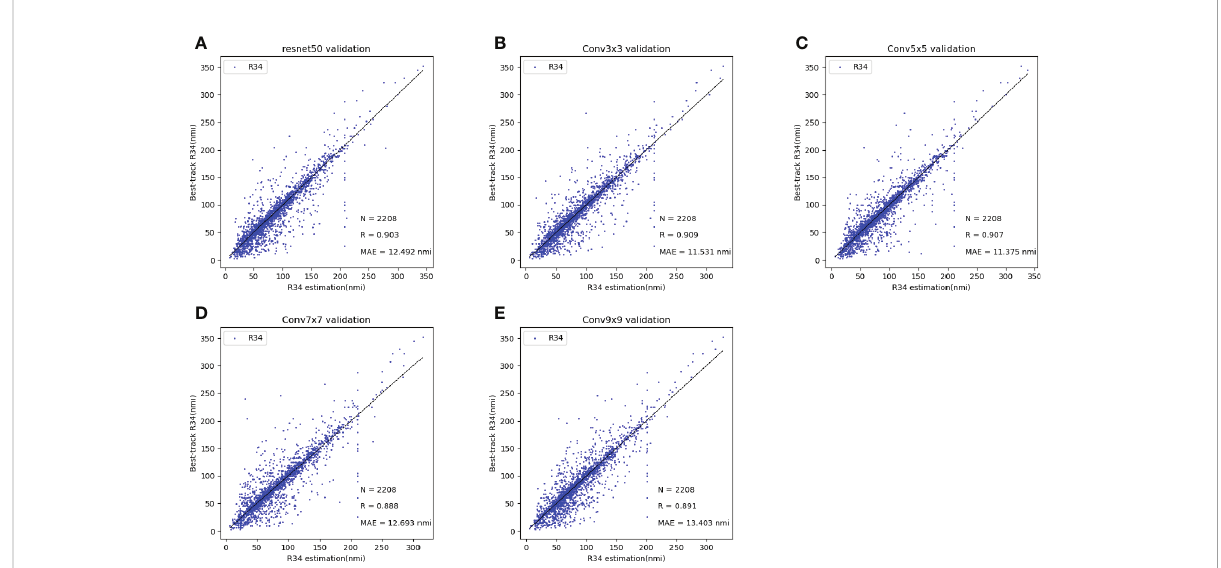
FIGURE 11 Scatterplot of different parameter settings on validation set. (A) Unimproved residual blocks, (B) with added 3 × 3 convolution kernel, (C) with added 5 × 5 convolution kernel, (D) with added 7 × 7 convolution kernel, and (E) with added 9 × 9 convolution kernel. In each fi gure, the horizontal axis is the R34 estimation of the model output, the vertical axis is the corresponding label, and the bottom-right corner shows the N, R, and MAE values.